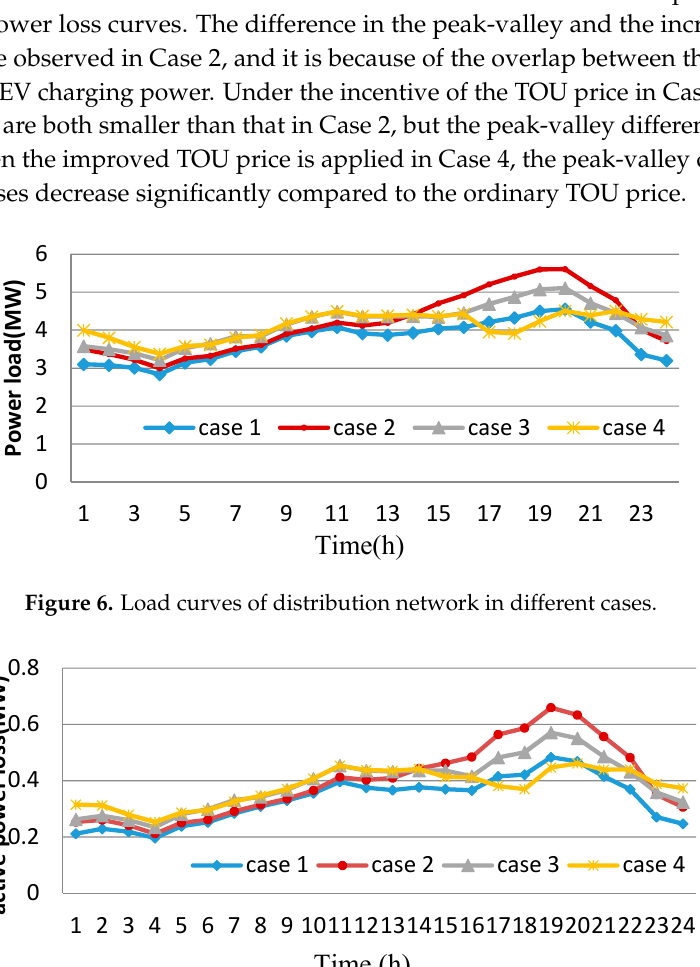
Figure 7. Active power loss curves of power distribution network in different cases.